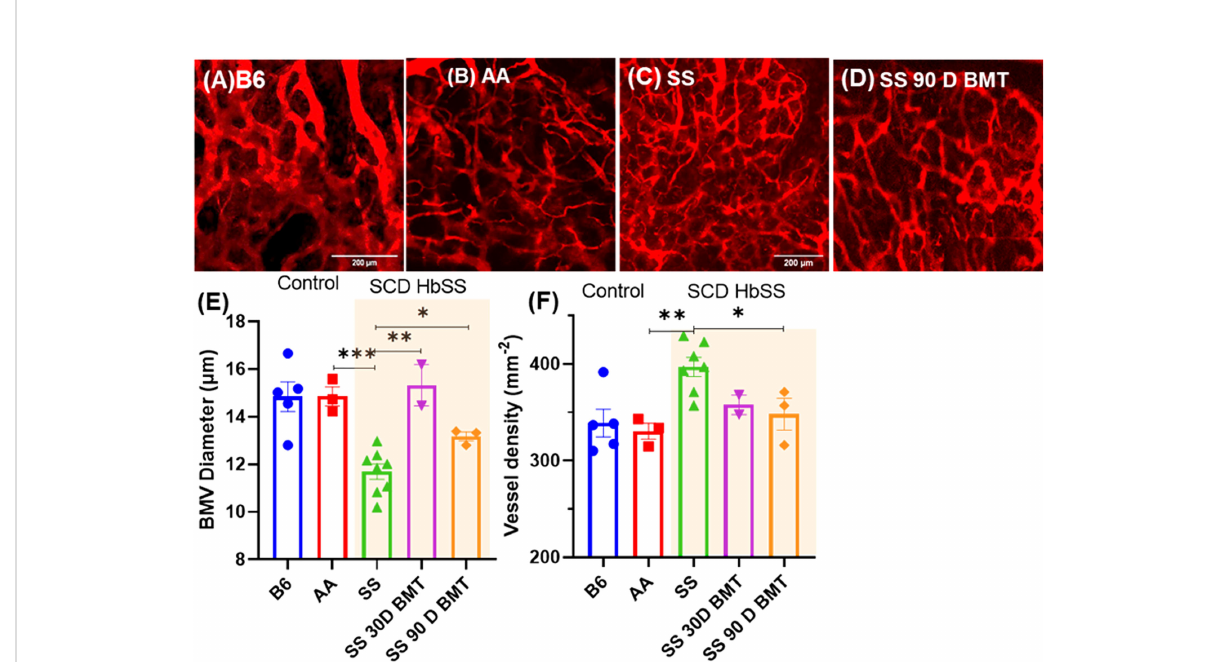
FIGURE 7 TPM imaging of microvasculature in SS mice and SS mice post-BMT. (A – D) TPM tiled images of SS mice and the controls, B6, AA, and 90 days post-BMT. The SCD mice have distinctly abnormal and disorganized BM vasculature (C) compared to that of control (A, B) ; however, 90 days post-BMT in TMI (8:2)-treated mice, the microvasculature of the SS mice recovered and was like that of control mice (D) . (E, F) Vascular diameter and the number of vessel branches per area were quanti fi ed for the statistical measures. Statistically signi fi cant difference between average vessel diameter can be seen between SCD mouse and their controls (E) and the same is true for the vessel numbers/density (F) . Data shown as mean ± SEM for n ≥ 3 mice in each group. Signi fi cance determined using two-tailed unpaired t -test and considered signi fi cant when p < 0.05, *p<0.05, **p< 0.01,